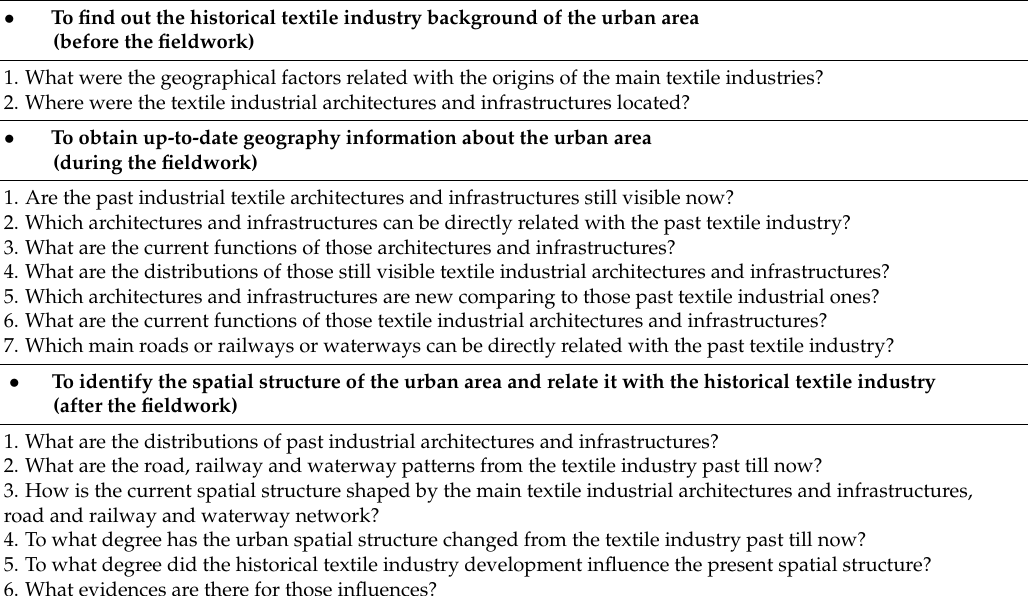
Table 2. Questions that need to be answered under the fieldwork